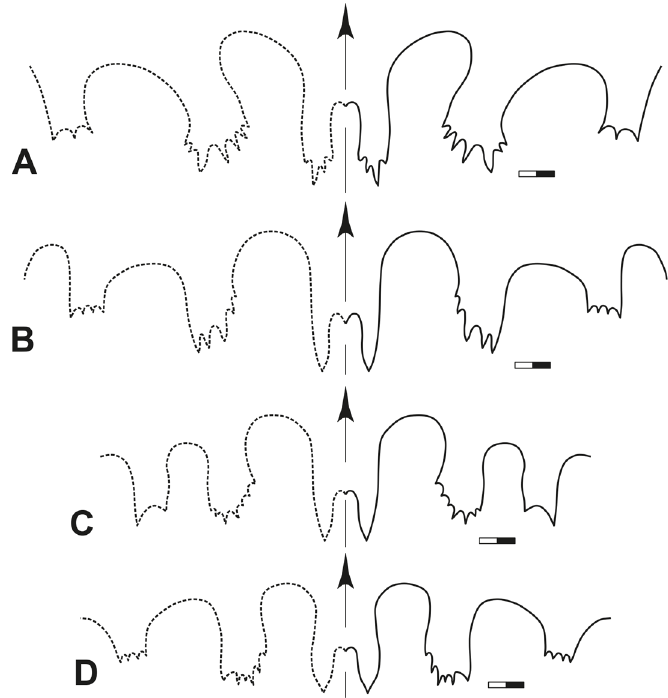
Fig. 49. Alibashites ferdowsii Korn & Ghaderi, 2016, suture lines. A . MB.C.29974, at 12.8 mm wh. B . MB.C.29980, at 10.9 mm wh. C . MB.C.29979, at 14.0 mm ww, 10.4 mm wh. D . MB.C.29987, at 10.3 mm wh. Abbreviations: see Material and methods. Scale bar units =